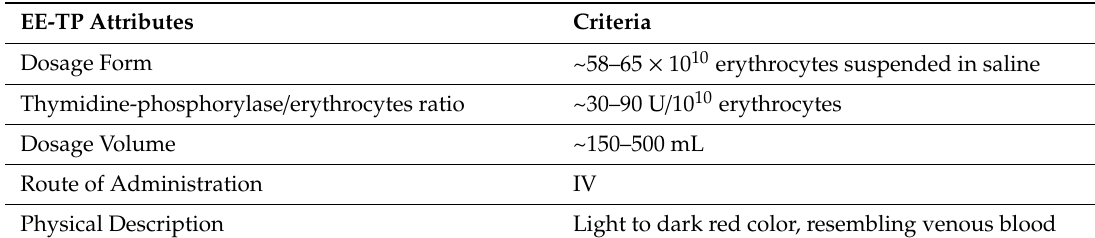
Table 1. Characteristics of EE-TP.